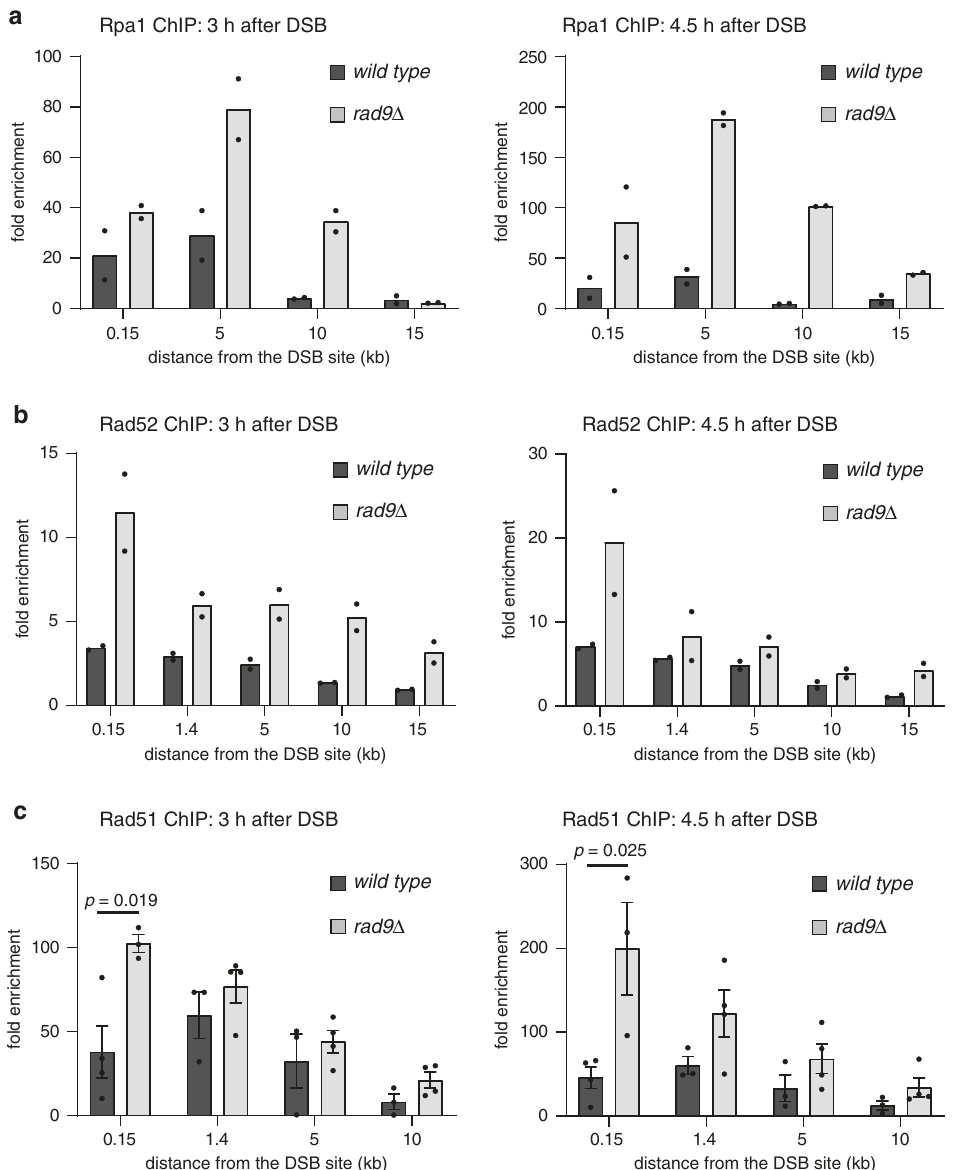
Fig. 3 Rad9 limits Rpa1, Rad52 and Rad51 hyper-loading at a DSB. ChIP analysis at the indicated positions from the cut site in JKM139 background, at 3 and 4.5 h following DSB induction, for the binding of a Rpa1-Myc ( n = 2, biologically independent experiments), b Rad52-HA ( n = 2, biologically independent experiments) and c Rad51 ( n = 3 for rad9 Δ and n = 4 for wild-type biologically independent samples). The indicated strains were blocked in G2/M with nocodazole. Data are mean ± SEM wherever n = 3 or more. Statistical analysis was done using unpaired two-tailed Student ’ s t -test. See accompanying Source data fi